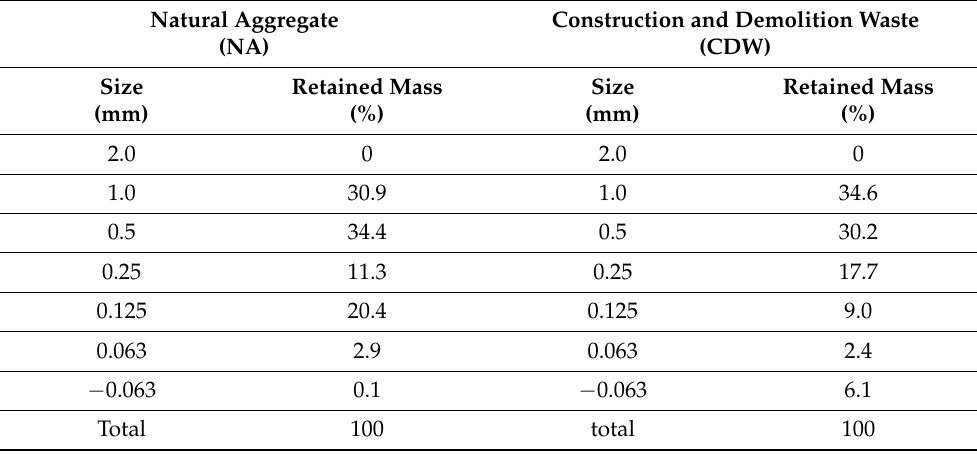
Table 1. Particle size distribution of CDW and natural aggregate (NA) particles calculated in this